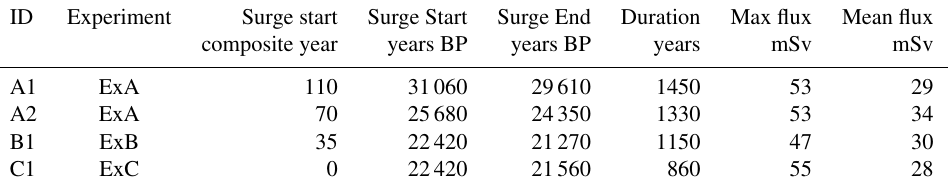
Table 1. Events investigated. The surge start is defined by the surge branching off the Ungava Bay ice stream and propagating towards Hudson Bay. Its time is given in years BP and as the year in the composite. The end of the surge is defined as the time when there is no more surging in Hudson Strait. The maximum flux is defined as the maximum of 30-year running means, matching Fig. 1b. ID Experiment Surge start Surge Start Surge End Duration Max flux Mean flux composite year years BP years BP years